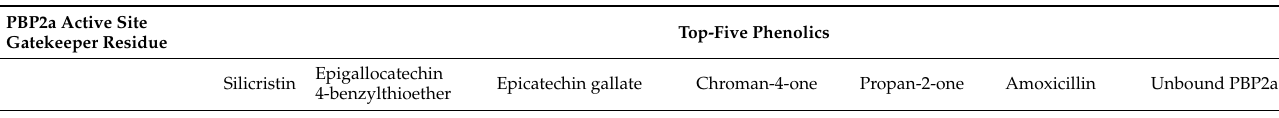
Table 6. PBP2a active site gatekeeper residue average fluctuation (Å) after 120 ns simulation of the top-five phenolics at the allosteric site.